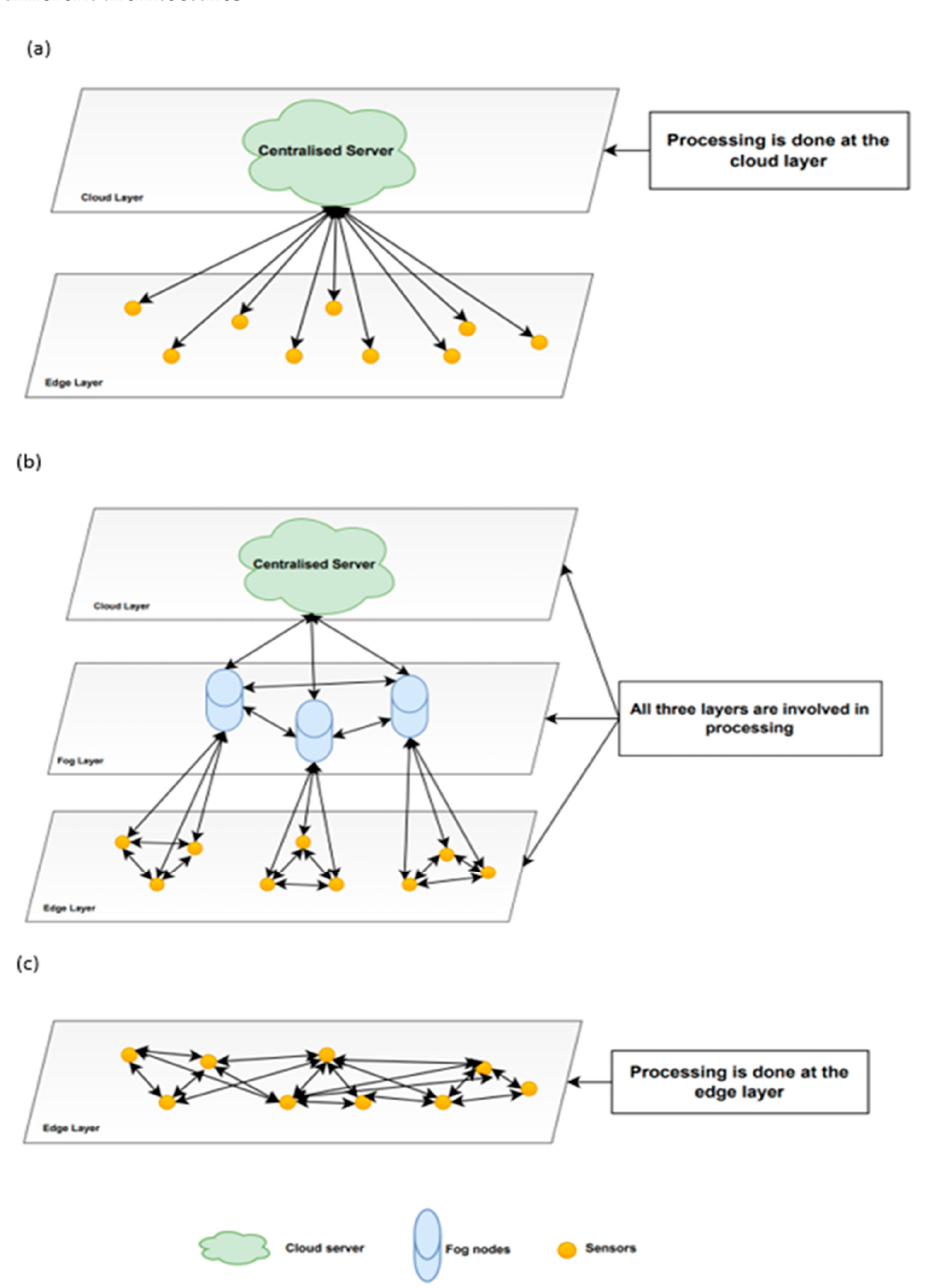
Figure 1. Illustrating different architectures and their layers: ( a ) centralised architecture, ( b ) typical decentralised architecture, and ( c ) proposed decentralised architecture.